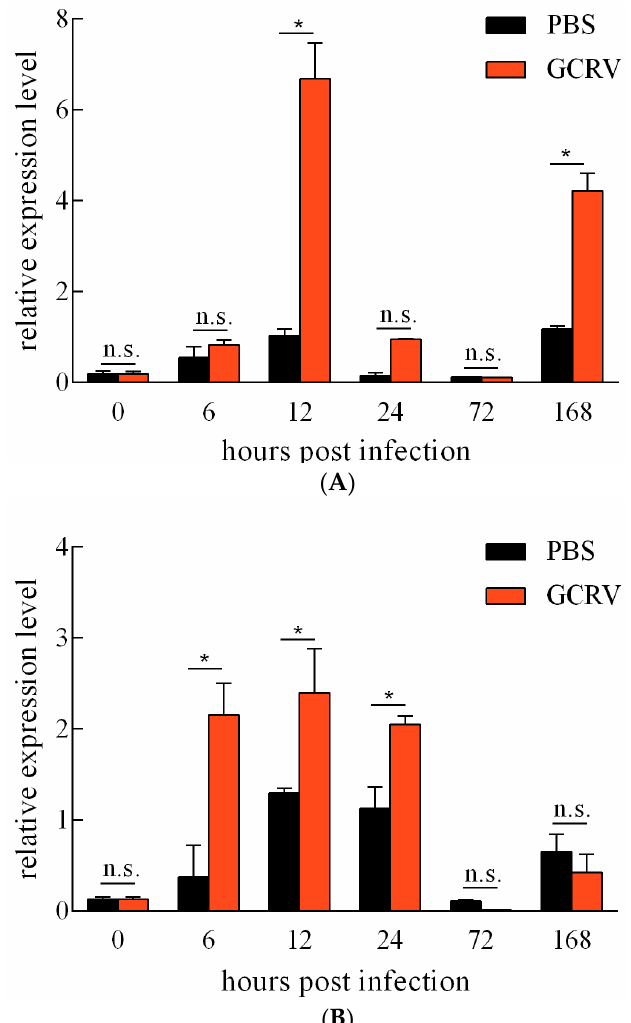
Figure 5. Expression level change in Ciferritin after PBS treatment and GCRV infection in the spleen ( A ) and the kidney ( B ). An asterisk (*) denotes a significant differences ( p < 0.05) between PBS and GCRV treatment groups and n.s. indicates no significant difference ( p > 0.05).